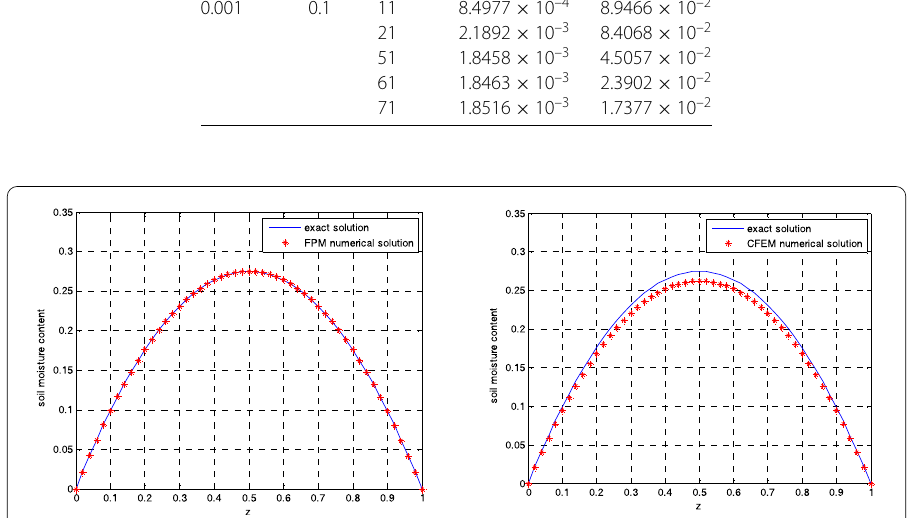
Figure 7 Comparison of results of FPM and CFEM in T = 0.1 and (cid:11) t =